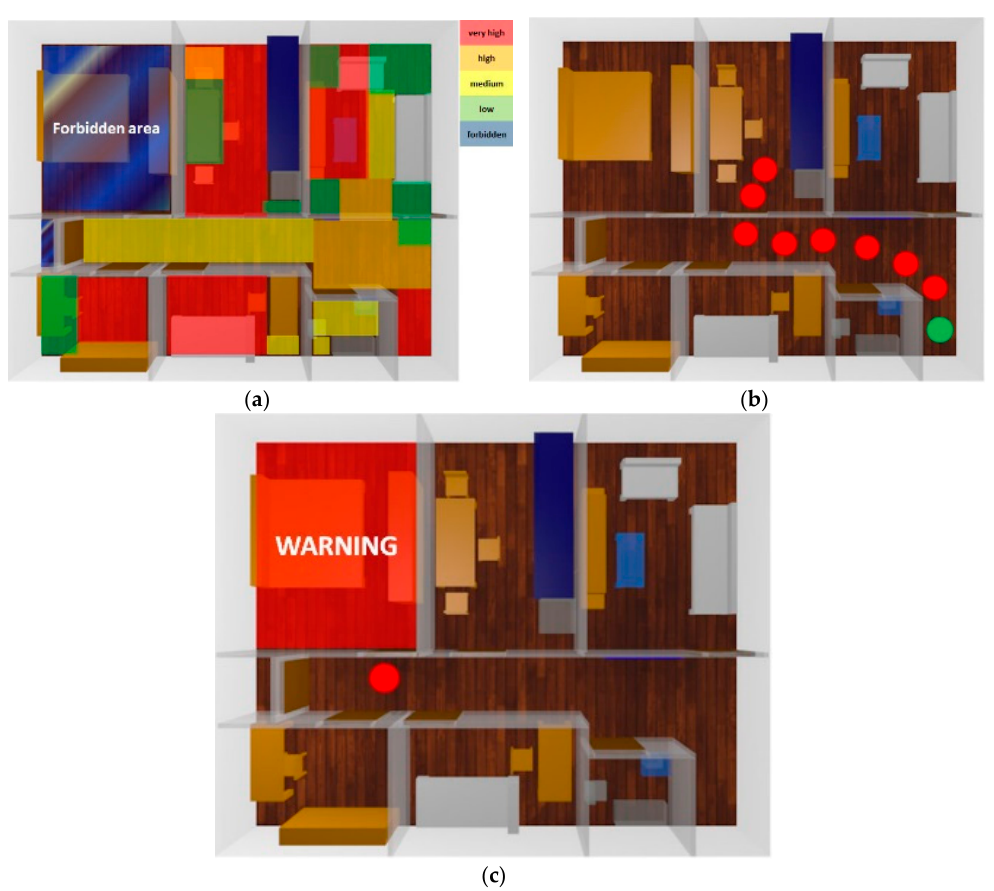
Figure 15. App functionalities: heat map ( a ), dog tracking ( b ) and forbidden area intrusion ( c